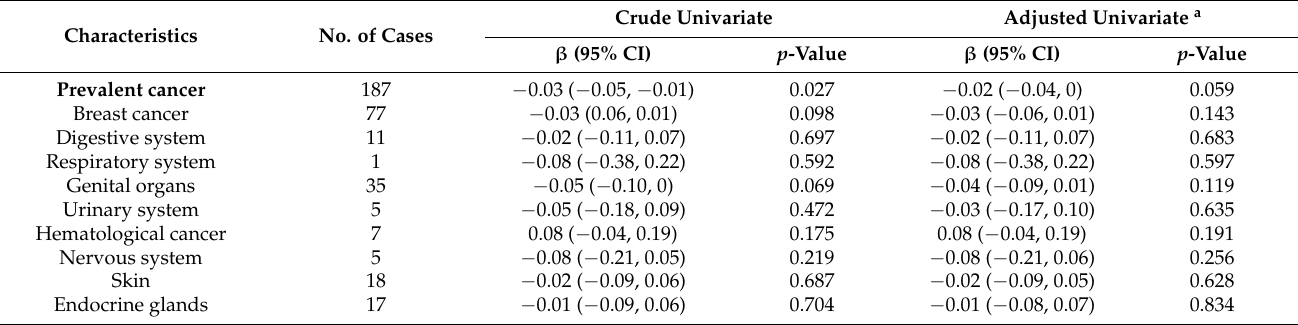
Table 3. Linear regression models examining association between prevalent cancer and telomere length.